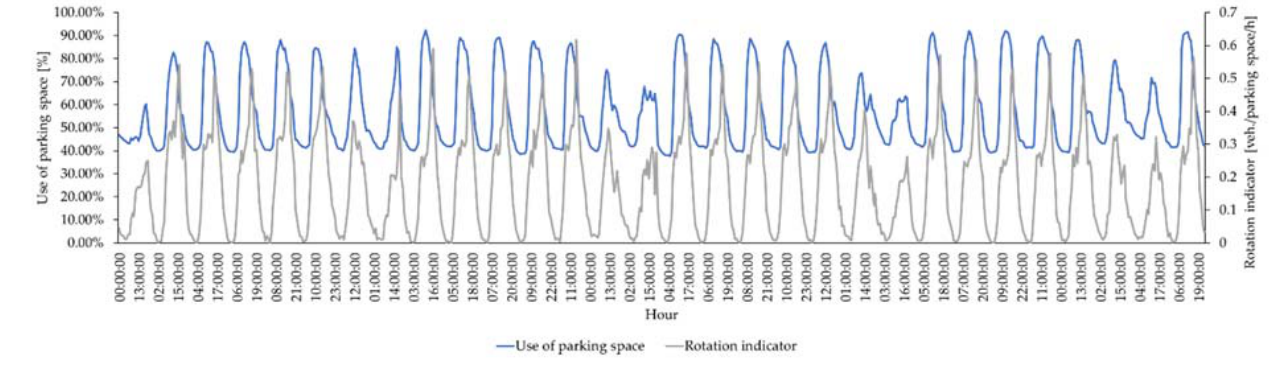
Figure 4. Use of parking space and rotation indicator in PPZ covered by DPI in September 2019.